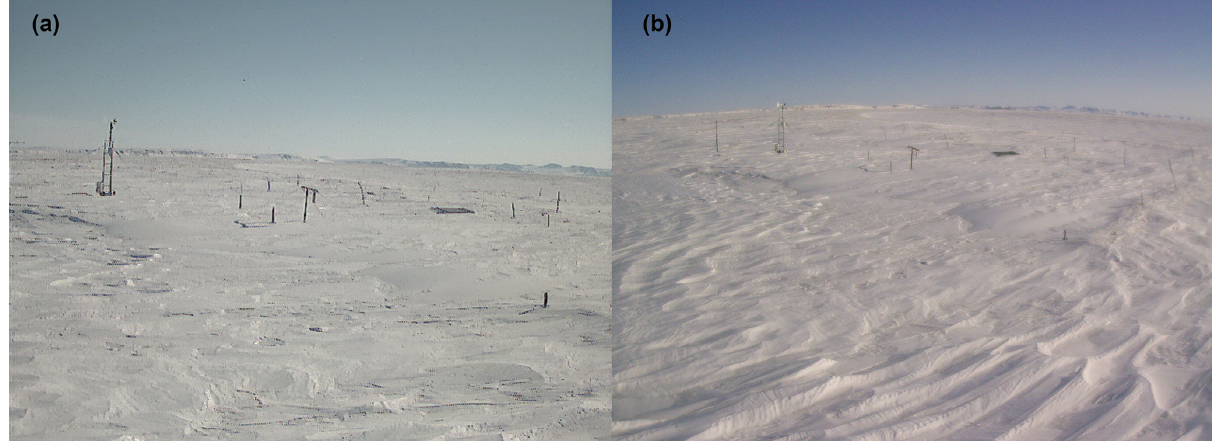
Figure B7. Examples of photos taken by cameras used for time-lapse photography (Fig. B5) showing winter field conditions. (a) Left photo taken by the Campbell Scientific CC640 camera (at a height of 2.2m) and (b) right photo taken by the Campbell Scientific CC5MPX camera (at a height of 3m) on 4 April